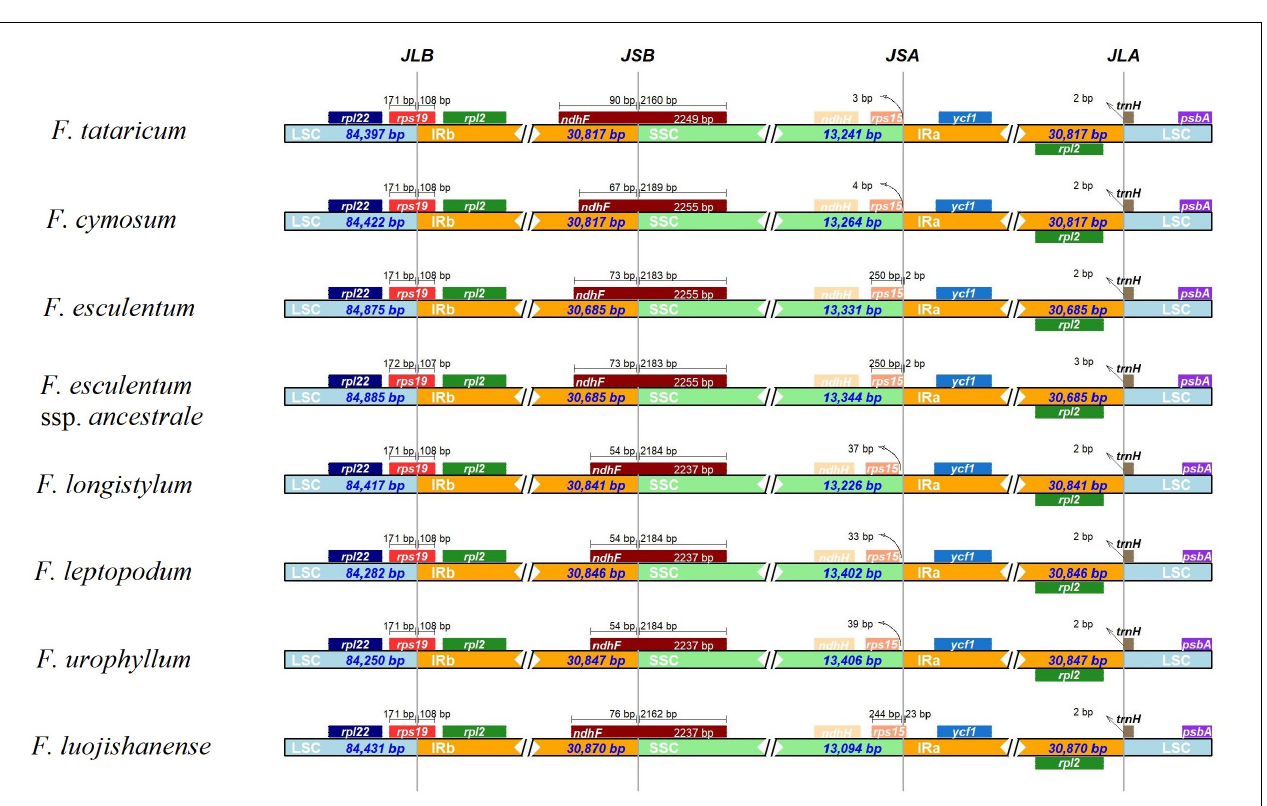
FIGURE 5 | Comparison of the junctions between the LSC, SSC, and IR regions among eight Fagopyrum species chloroplast genomes. The figure is not scaled LSC, SSC, and